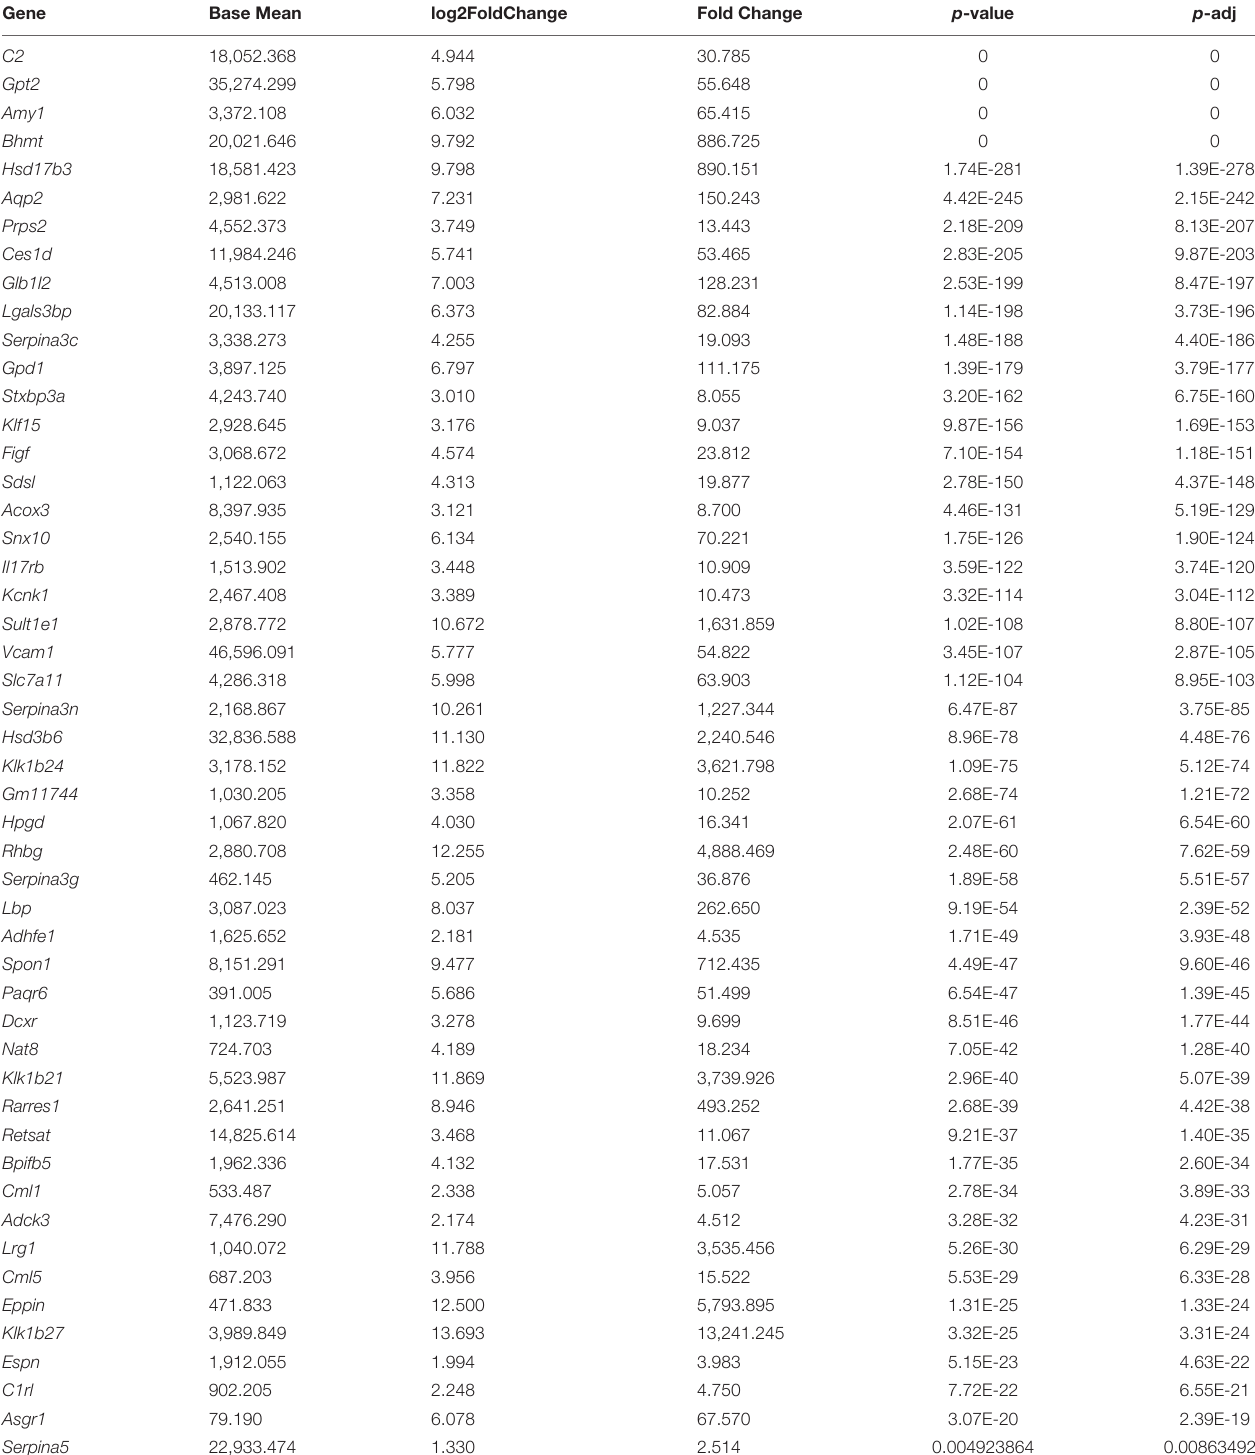
TABLE 2 | Adult Leydig cells (ALC) specific